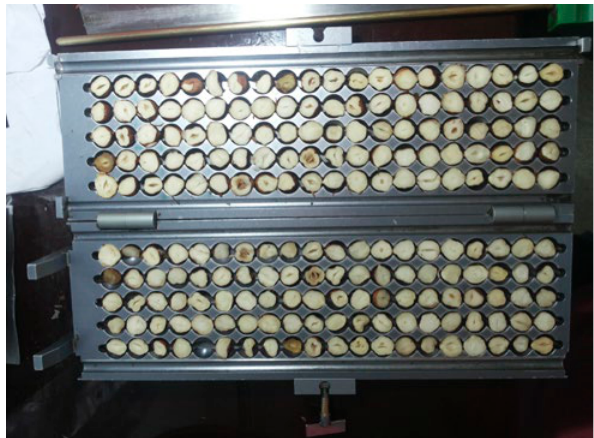
Figure 1. Shelled hazelnuts cut in half to observe internal defects. Based on these assessments, the nuts were catego- rised into two groups, as healthy (no defects) or